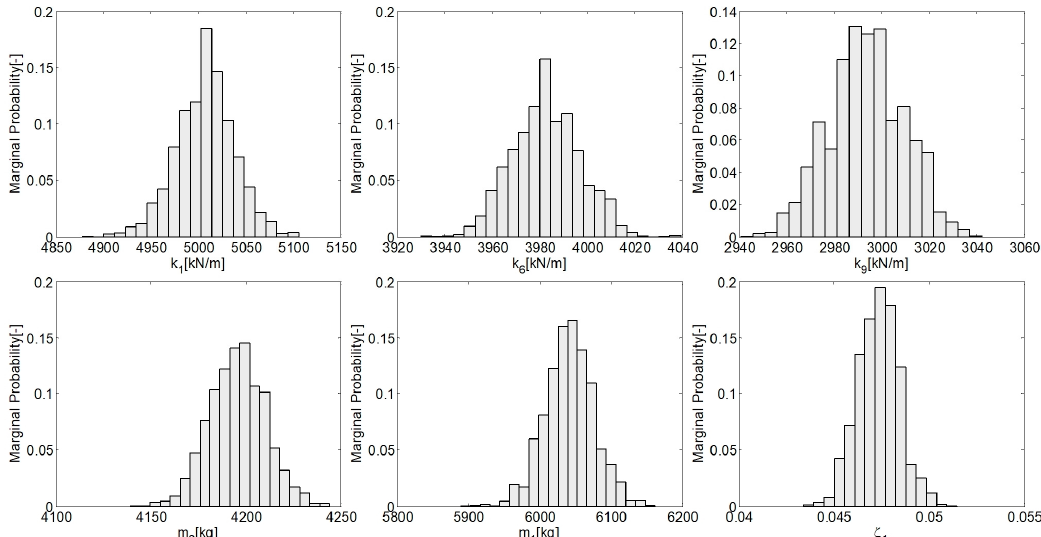
Figure 8. Marginal posterior probability distributions of the six estimation parameters ( k 1 , k 6 , k 9 , m 1 , m 6 , ζ 1 ).